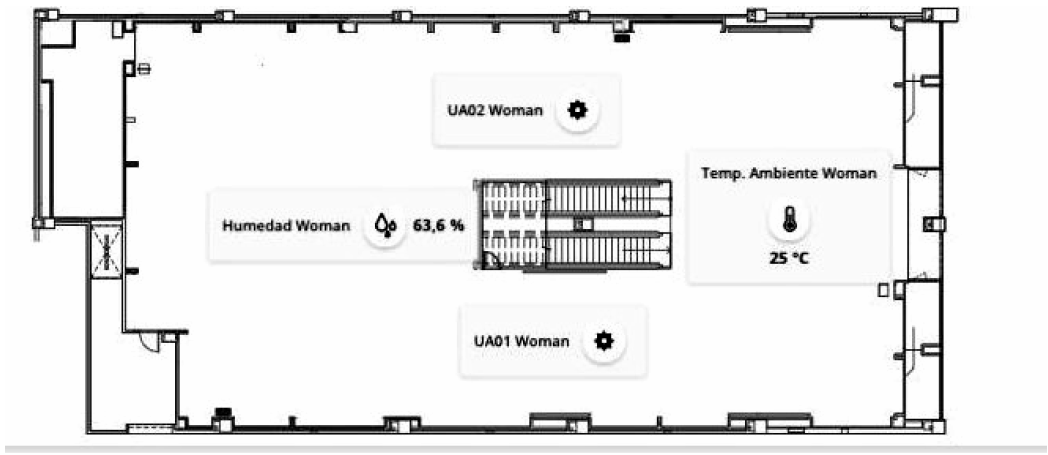
Figure 1. Plan of the case study store located in the Panama